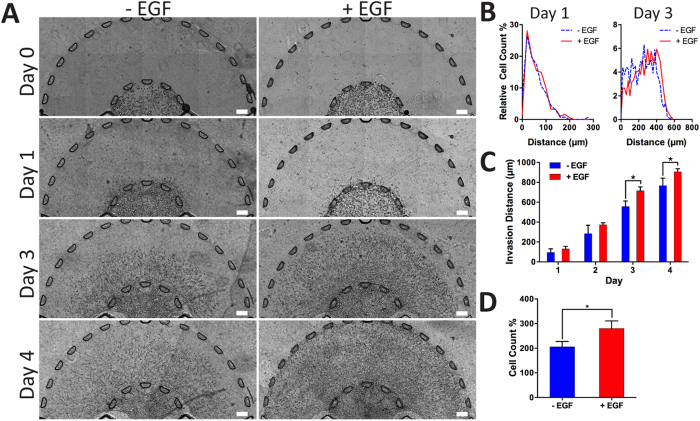
Breast cancer 3D invasion assay.(A) Devices were split into two groups where one group (+EGF) was introduced to EGF (50 ng/mL) and the other was not exposed to EGF (− EGF). Based on the representative images, (+) EGF showed more proliferation, as indicated by the higher density, and migration by reaching to the outer channels in 4 days. The (−) EGF group demonstrated migratory tendencies but did not have the same invasive profile as (+) EGF. (B) Distribution of cells was quantified for days 1 and 3. The profiles were similar between (−) and (+) EGF for the first day. By the third day, there was a shift in cell distribution toward the right indicating a higher cell count further away from the tumor region. It was not possible to quantify the distribution for the fourth day due to the high density and overlapping cells (scale bar: 100 μm). (C) Invasion distance of the tumor front was calculated from the radial distances of the furthest cells from the tumor region. (+) EGF exhibited significantly higher invasion by days 3 and 4 (p < 0.05 calculated from Student’s t-test with more than three devices for each condition). (D) Number of cells of cells was quantified on days 1 to 3 with (+) EGF leading to a significantly higher cell count (p < 0.05 calculated from Student’s t-test with more than three devices for each condition).